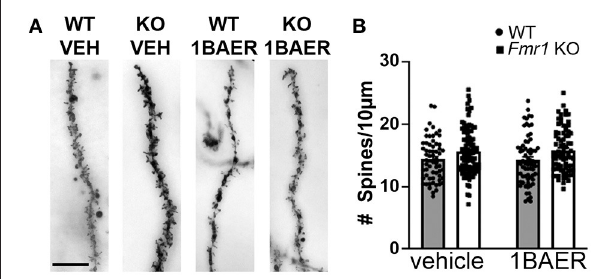
FIGURE 3 | Increased dendritic spine density in Fmr1 KO hippocampus is not affected by short-term treatment with low-dose BAER-101. Dendritic spine density on apical CA1 hippocampal dendrites from Fmr1 KO and WT mice after 10 days of daily treatment with vehicle or 1 mg/kg BAER-101 (1BAER) was visualized by Golgi staining and quantified by manual counting using ImageJ. Representative images are shown in (A) quantifications in (B) . Dendritic spine density is increased in Fmr1 KO mice but not changed by BAER-101 treatment [2-way ANOVA, p (treatment) = 0.87; p (genotype) = 0.0013, p (interaction) = 0.72]. Scale bar is 10 µ m. WT vehicle: n = 61 dendrites from 5 mice (12–13 dendrites each); Fmr1 KO vehicle: n =